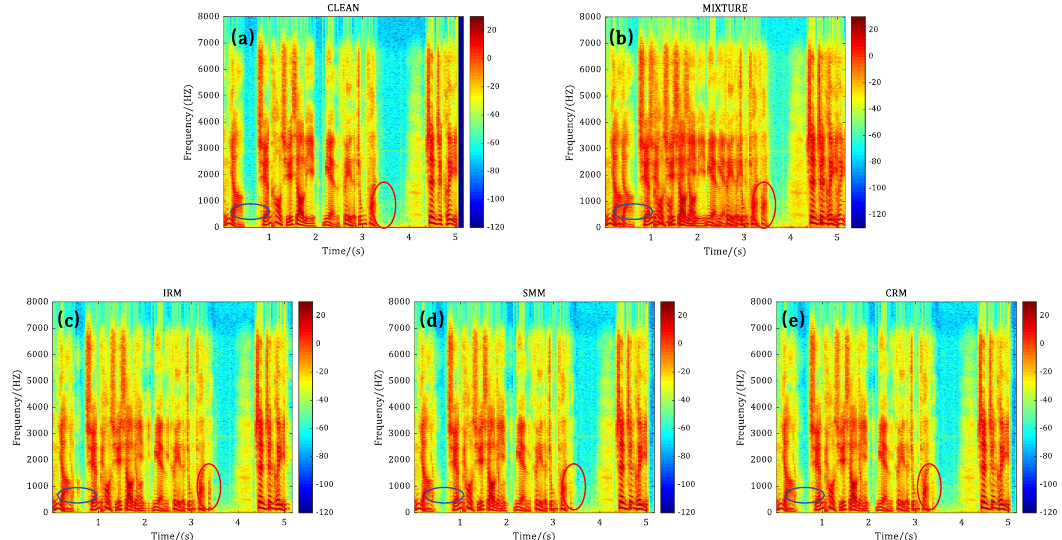
Figure 5. The spectrograms of test data No. 461 obtained by AC-DNNs with different training targets. ( a ) clean signal. ( b ) noisy signal. ( c ) processed with IRM target. ( d ) processed with SMM target. ( e ) processed with CRM